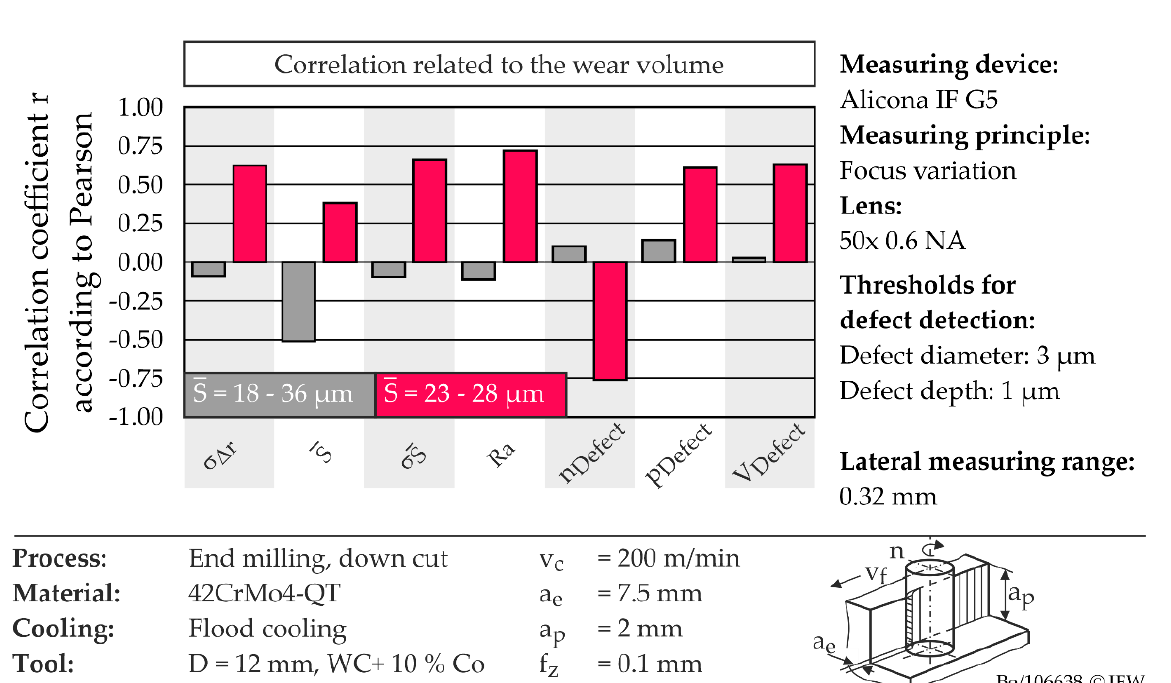
Figure 12 gives an overview of the calculated Pearson coefficients between the different edge quality characteristics and the mean wear volume, depending on the considered parameter range of the cutting edge rounding.